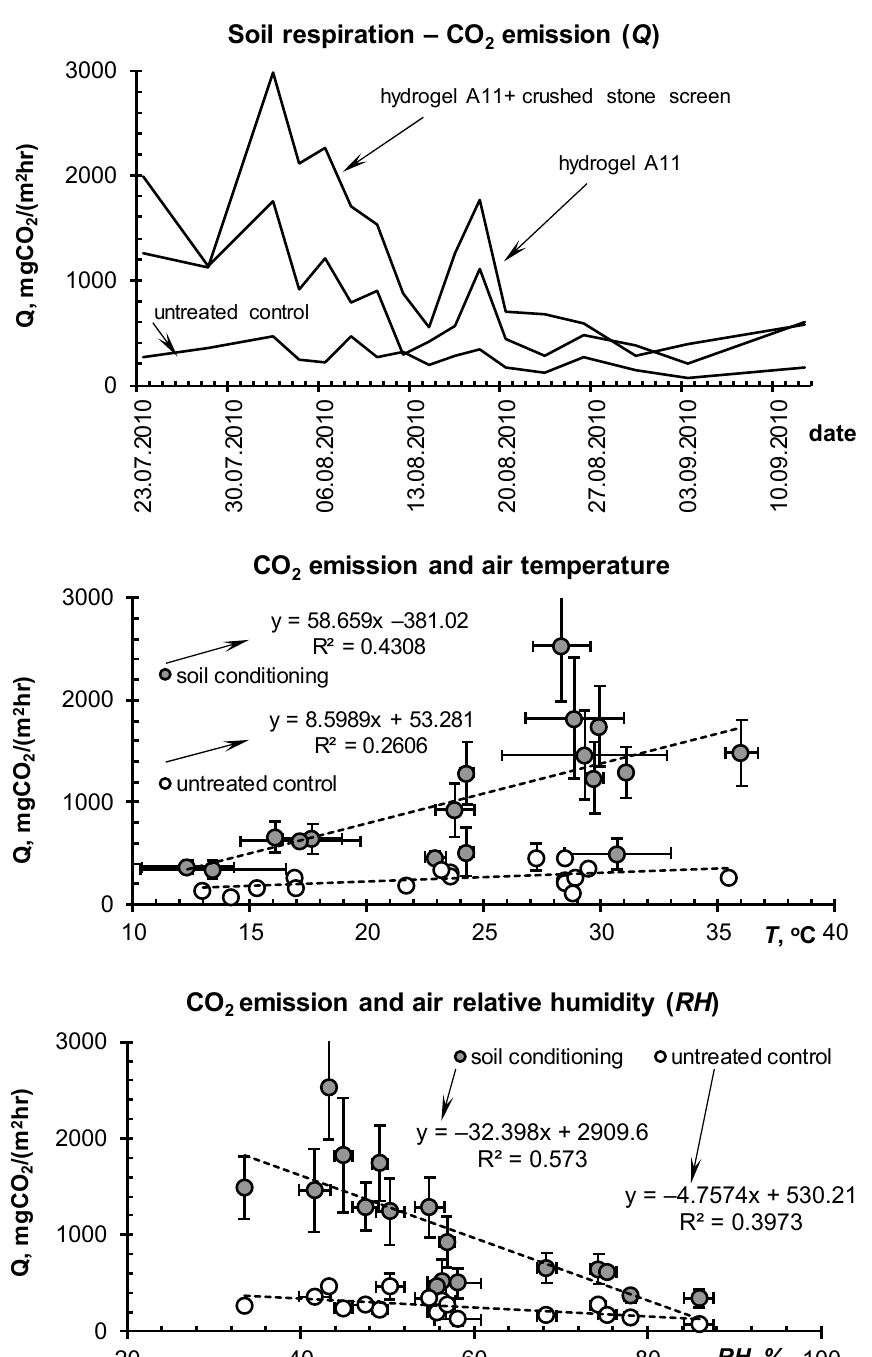
Figure 7. Soil respiration under the influence of A11 hydrogel and controlling factors of temperature and air humidity.